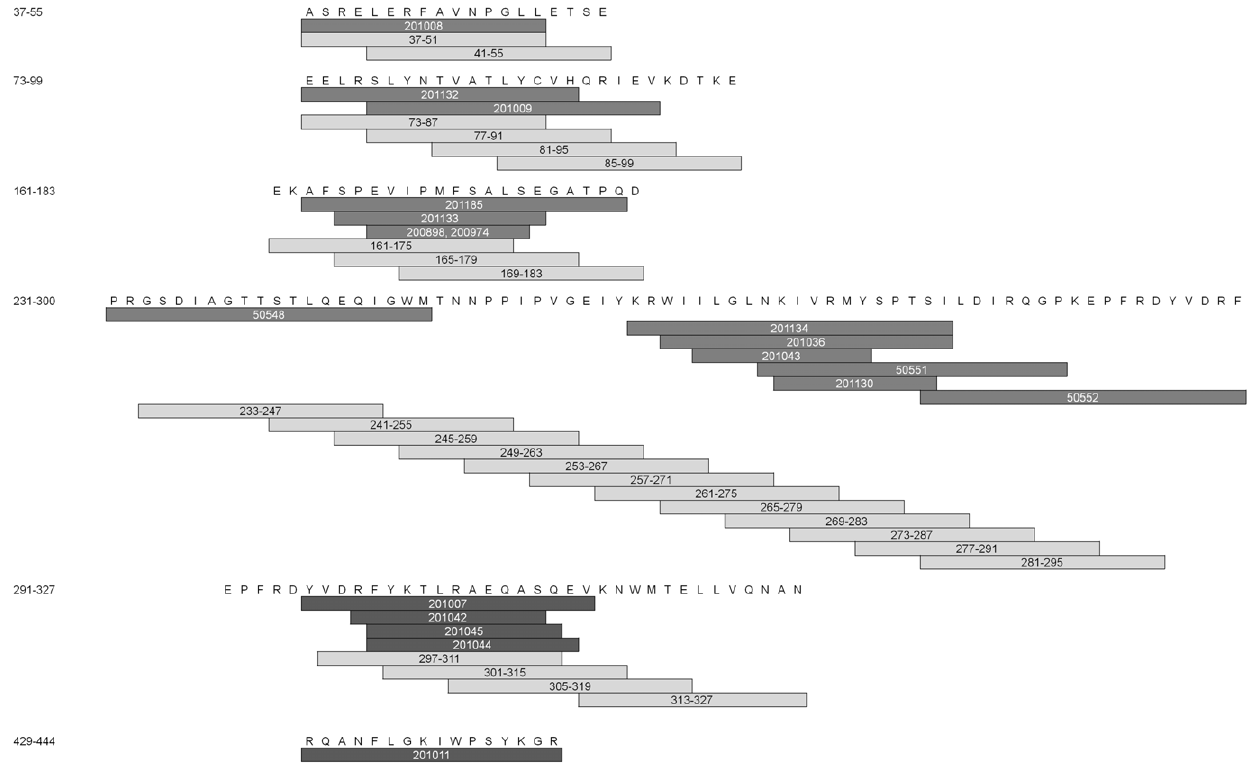
Figure 3. Correlation of known human DR4 CD4 epitopes to ELISpot positive peptides from HLA-DR4 transgenic mice. Previously published CD4 + epitopes of HIV infected patients were aligned with IFN- c ELISpot positive peptide from DR4 mice immunized with LAMP/gag transfected immature DC and plasmid LAMP/gag boost (dark grey bars - known human sequence with HIV molecular immunology database accession number labeled inside, light grey bars - ELISpot positive peptides with the peptide number labeled